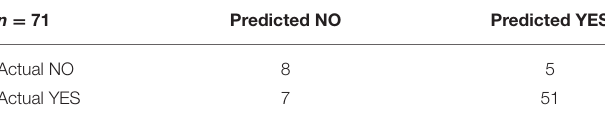
TABLE 4 | Confusion matrix for the posture validation study. n = 71 Predicted NO Predicted YES Actual NO 8 5 Actual YES 7 51